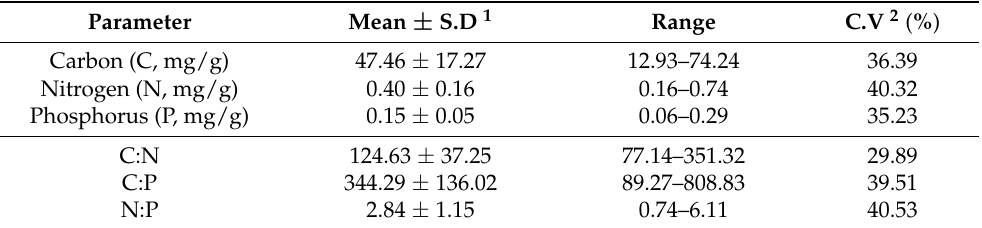
Table 3. The content and stoichiometry characteristics of carbon, nitrogen and phosphorus in soil.